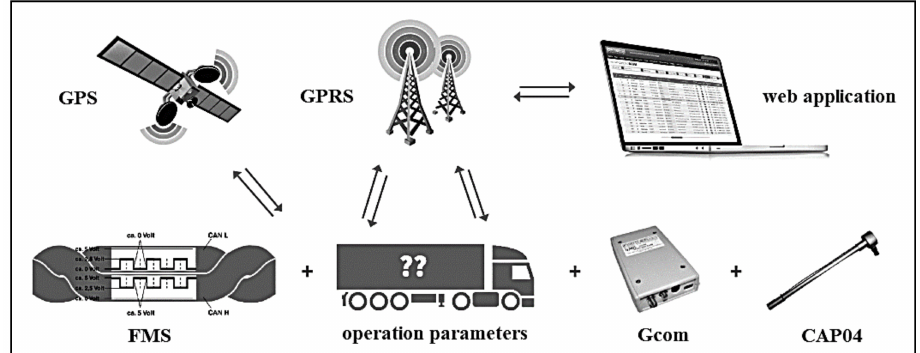
Figure 1. Graphical depiction of the functions of the RMC system and the communication of its components